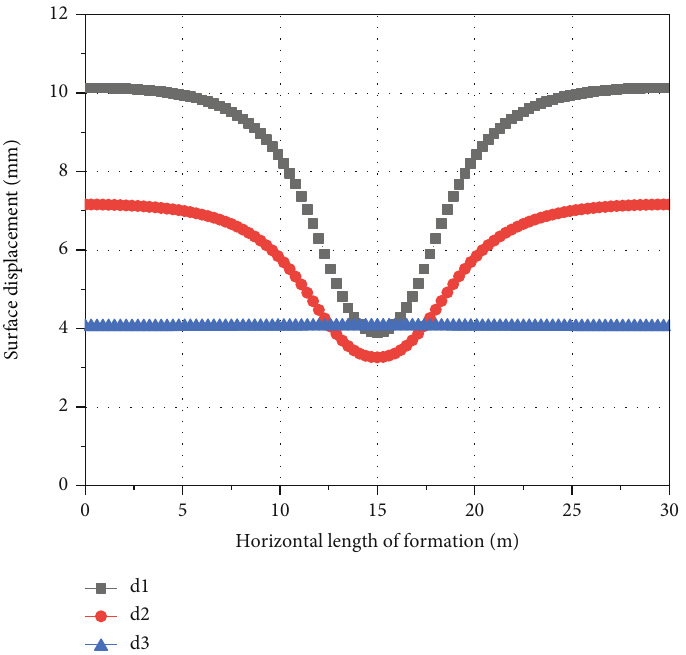
Figure 17: E ff ect of rising groundwater level on surface